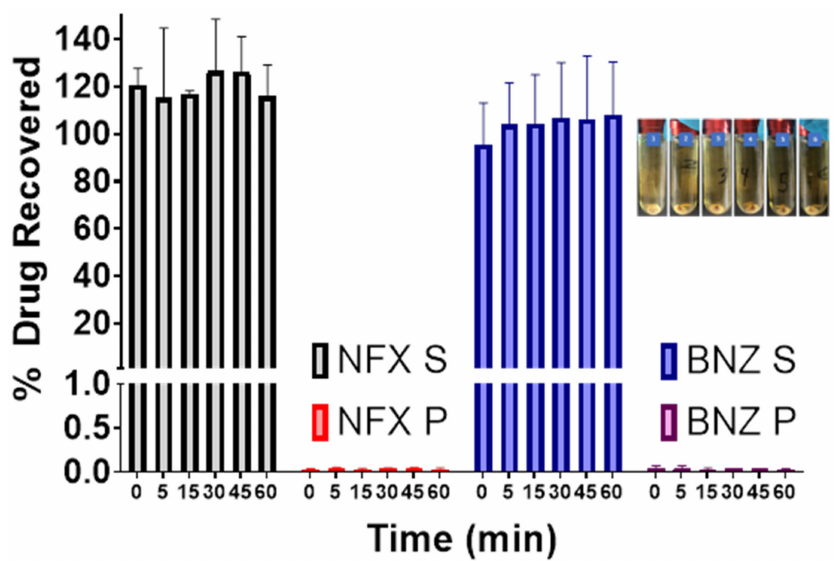
Figure 4. In vitro lipolysis of NFX-BNZ SNEDDS with grey and red bars illustrating the % of NFX and blue and purple bars illustrating the % of BNZ recovered in the aqueous supernatant phase (S) and pellet (P) respectively ( n = 3). Picture shows samples after ultracentrifugation in progressive time order of 0, 5, 15, 30, 45 and 60